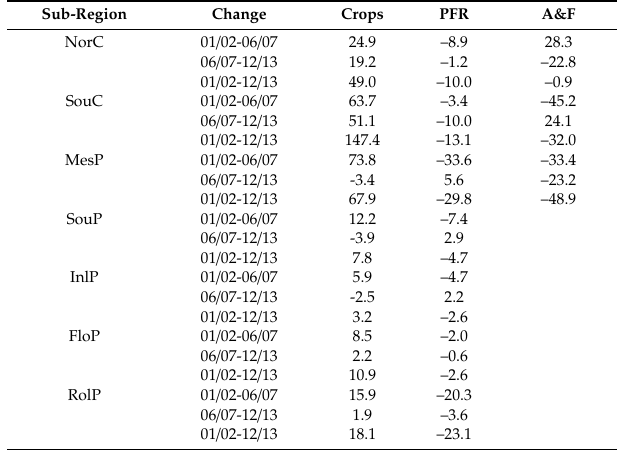
Table 7. Relative change, expressed as a percentage, on the surface of mapped categories for the di ff erent RPG sub-regions and for di ff erent periods of time. 01 / 02–06 / 07 represents the changes that occurred between 2001 / 2002 and 2006 / 2007. 06 / 07–12 / 13 represents the changes that occurred between 2006 / 2007 and 2012 / 2013. 01 / 02–12 / 13 (in bold) represents the changes that occurred between 2001 / 2002 and 2012 / 2013. Change refers to the period analyzed for the calculation of the relative change. Crops group the categories Winter Crops, Summer Crops, and Double Crops. PFR: Perennial Forage Resource. A&F: A ff orestation and Forest. NorC: Northern Campos; SouC: Southern Campos; MesP: